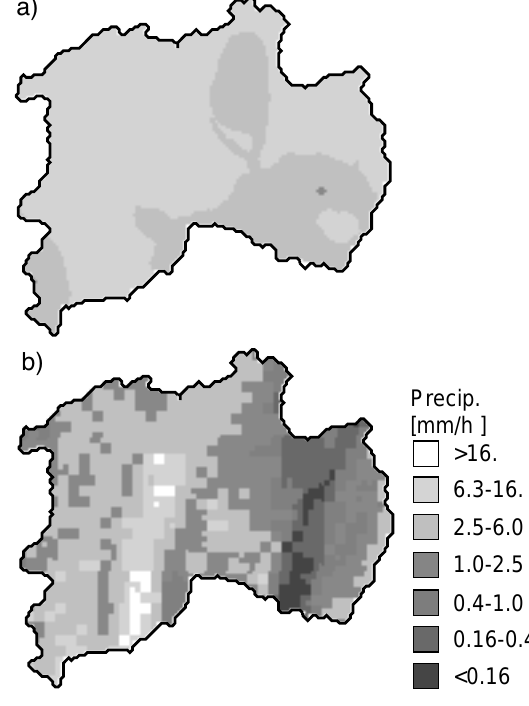
Fig. 4. Hourly accumulated precipitation fields for 20 September 1999, 12:00 to 13:00UTC in mm/h as derived from (a) rain gauge station data and (b) from radar data in the TVM